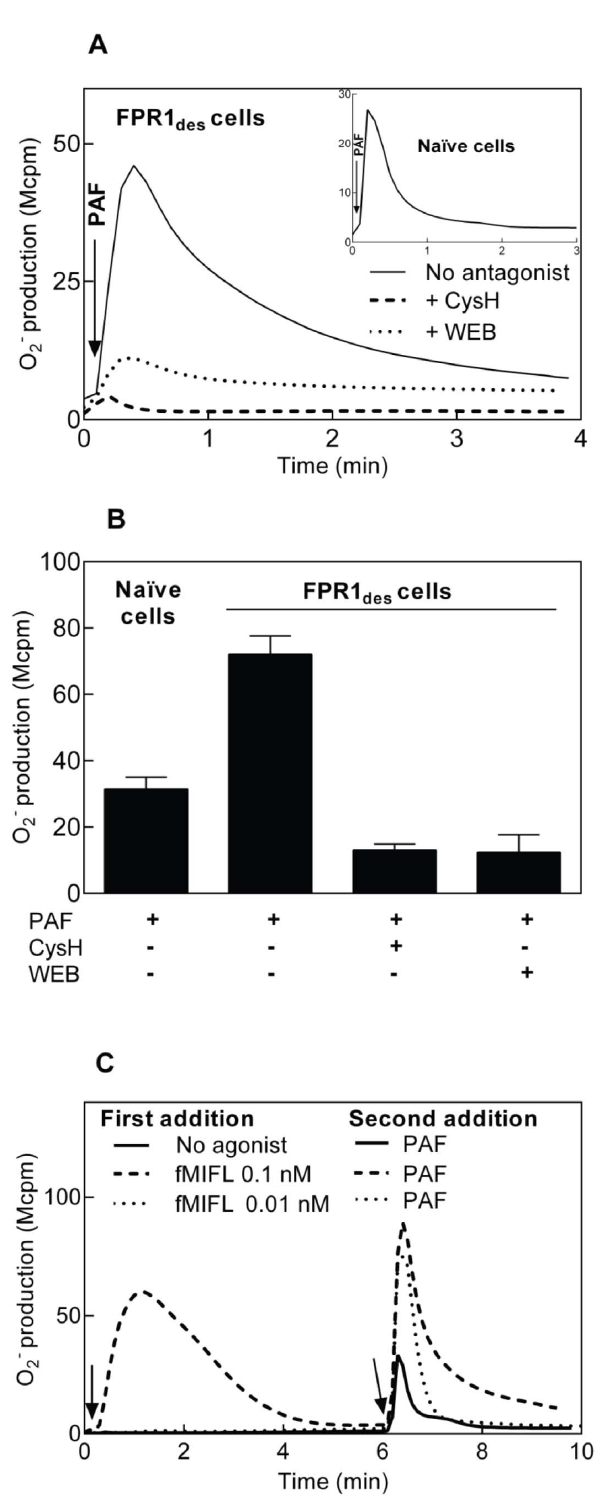
Figure 2. Receptor cross talk from the PAFR induces reactiva- tion of FPR1 des . Human neutrophils (10 5 ) were desensitized with the FPR1 agonist fMIFL (0.1 nM) as described in Figure 1. ( A ) The FPR1 des neutrophils were activated with PAF (100 nM, added at time indicated by arrow; solid line). The involvment of FPR1 and PAFR in the PAF- induced response was examined by addition of cyclosporin H (1 m M, FPR1 antagonist, broken line) or WEB2086 (1 m M, PAFR antagonist, dotted line) at 3 min prior to PAF addition. For comparison,